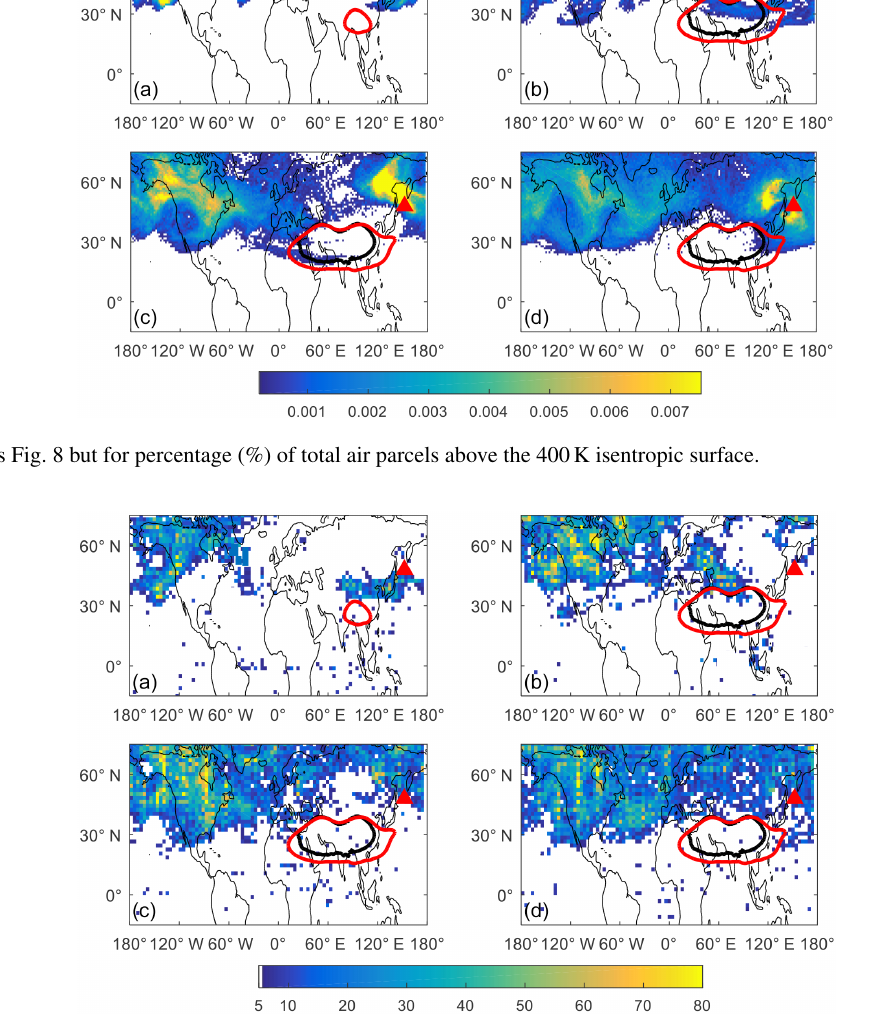
Figure 11. Same as Fig. 9, but for number of data points above the 400K isentropic